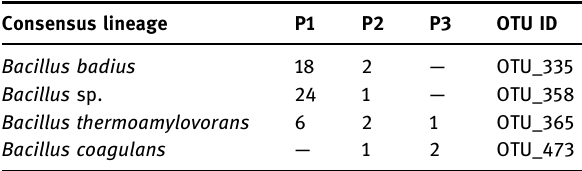
Table 5: Genus Pseudomonas were identi fi ed from the GI tracts of